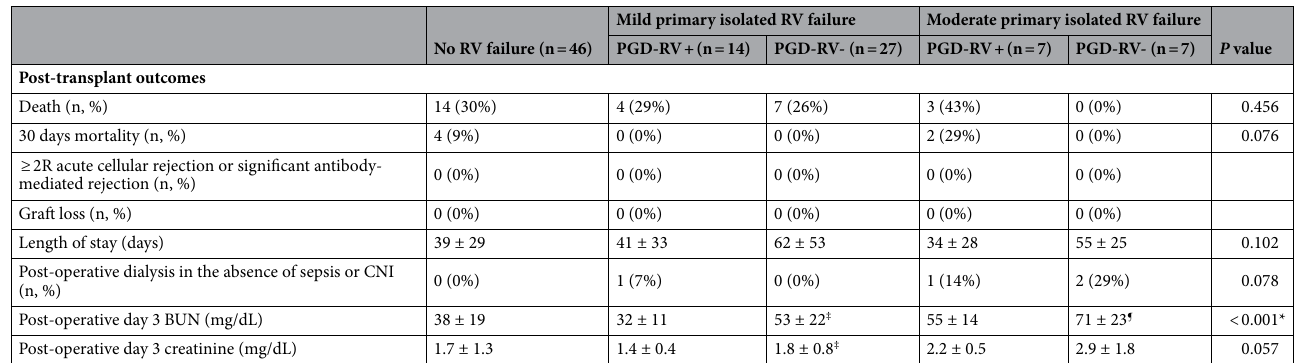
Table 4. Post-transplant clinical outcomes. BUN blood urea nitrogen, CNI calcineurin inhibitor, RAP right atrial pressure, RV right ventricular. PGD-RV + : patients who met the criteria of PGD-RV; PGD-RV-: patients who did not meet the criteria of PGD-RV. ‡ P value < 0.05, compared between patients with mild PGD-RV and mild isolated RV failure with no PGD. ¶ P value = 0.08, compared between patients with moderate PGD-RV and moderate isolated RV failure with no PGD. * P ANOVA <